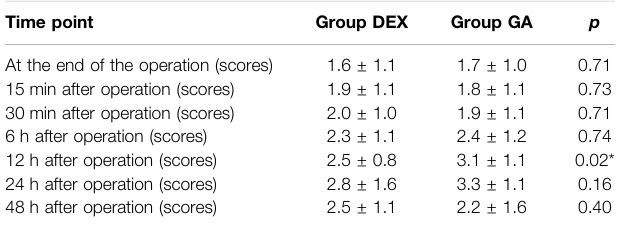
TABLE 3 | Comparison of the postoperative visual analogic scale scores (Mean ± SD). Time point Group DEX Group GA p At the end of the operation (scores)